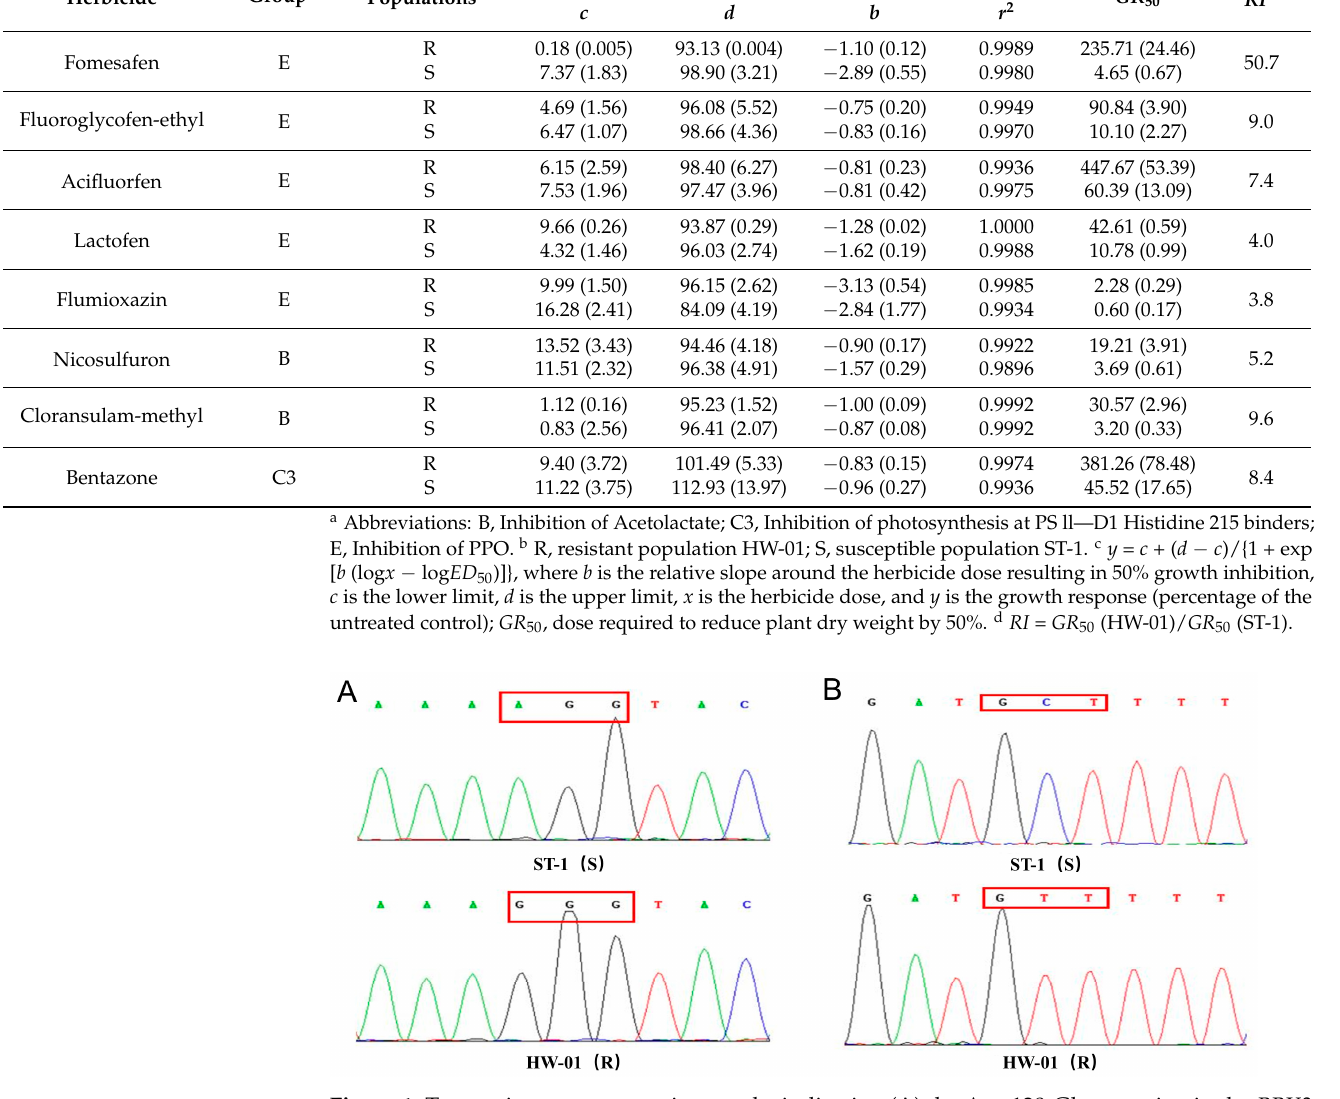
Figure 1. Target-site gene sequencing results indicating ( A ) the Arg-128-Gly mutation in the PPX2 gene, ( B ) the Ala-205-Val (frequency of 40%) in the ALS gene in HW-01 (R), compared with ST-1(S). Table 3. Parameter values of the four-parameter log-logistic equation to calculate the GR 50 values of the susceptible (ST-1) and resistant (HW-01) populations of A. retro fl exus with the use of the whole- plant dose–response experiments. Standard errors (SE) are in parentheses.